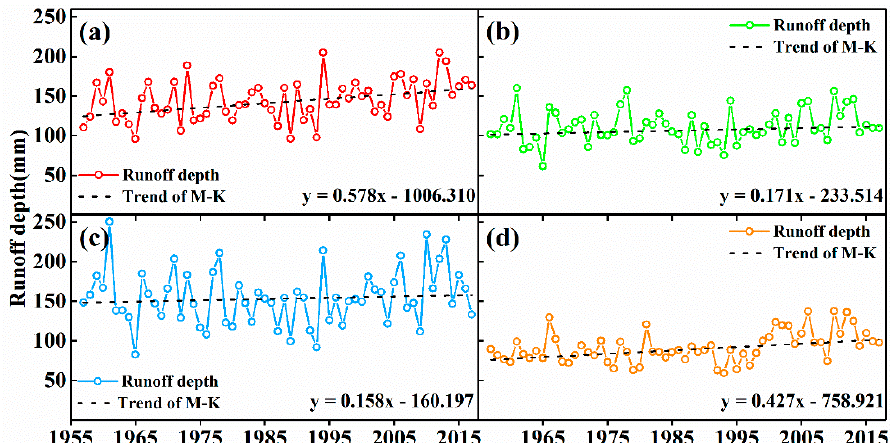
Figure 9. Runoff depth variation of the ( a ) YRK, ( b ) KRK, ( c ) YUK, and ( d ) KRY in 1957–2017.